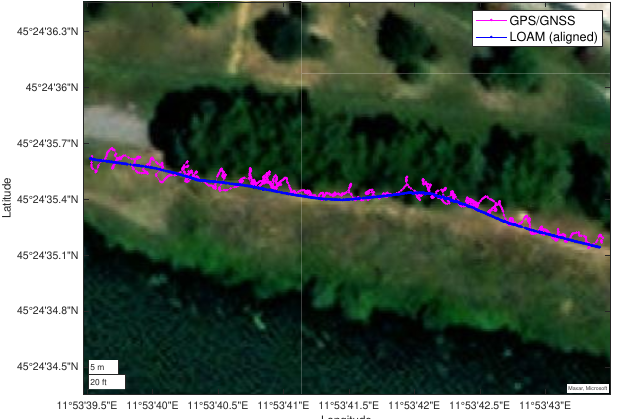
Figure 12. Visual ( left ) and thermal ( right ) images of the outdoor environment used to test the proposed algorithm.